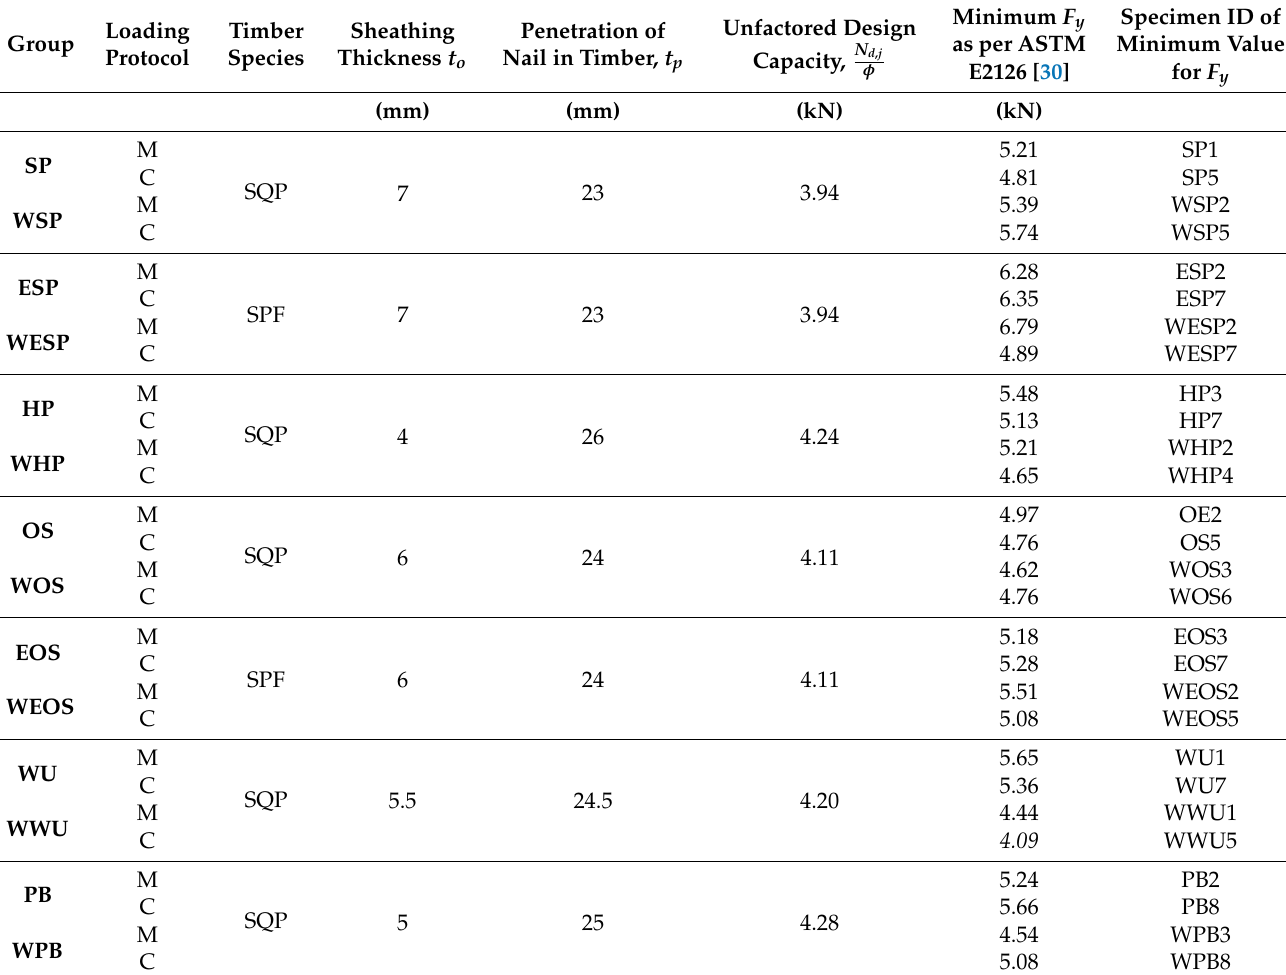
Table 6. Unfactored design capacity and minimum yield load per